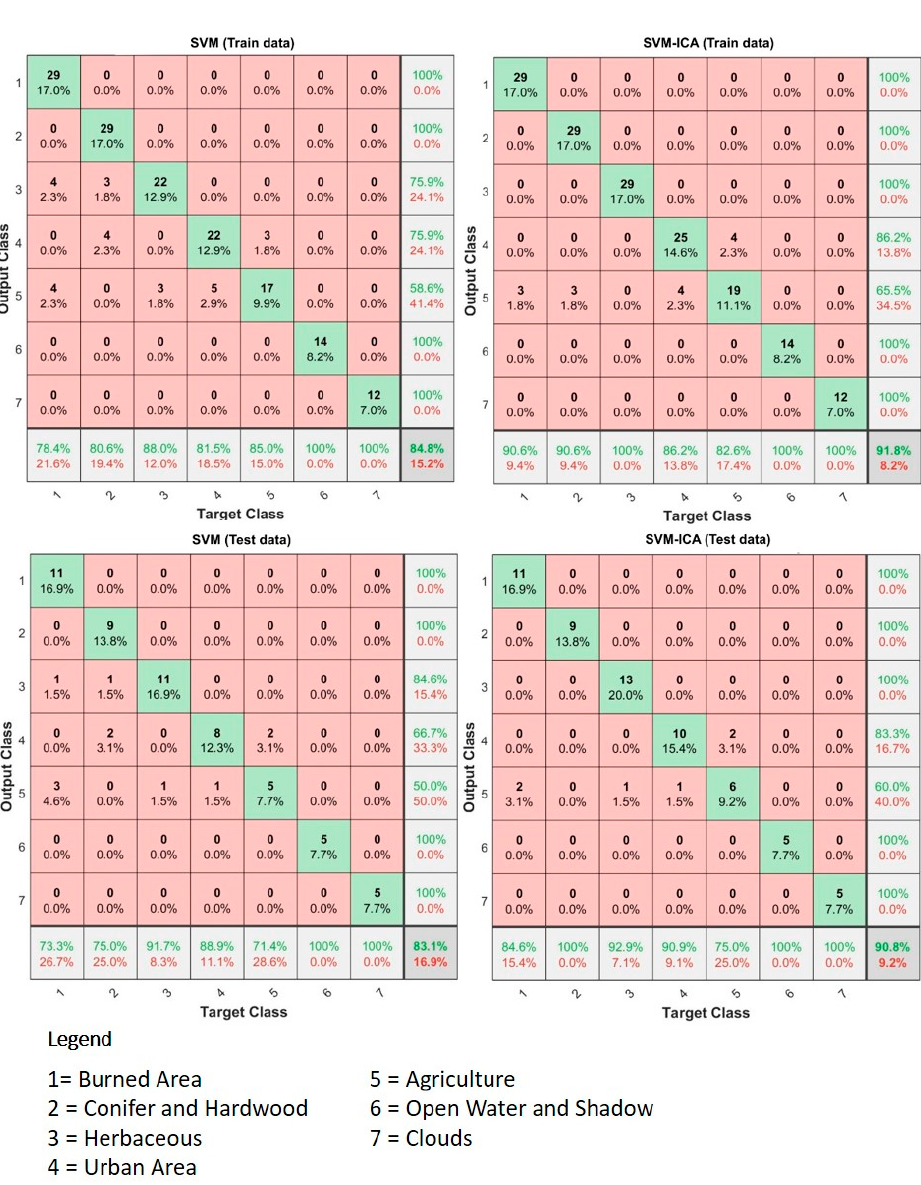
Figure 12. Overall accuracy of the post ‐ wildfire classification by SVM and SVM–ICA from Sentinel ‐ 2